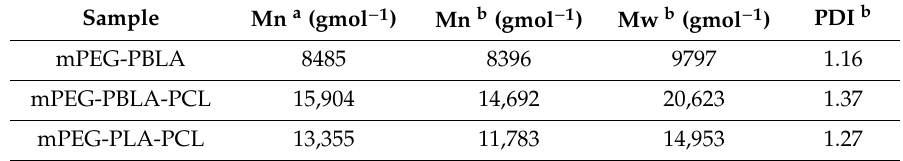
Figure 2. Raman shift of mPEG-P(LA-DSeDEA)-PCL ( A ) and APC traces of block copolymers ( B ). Table 1. Molecular weight and polydispersity profiles of synthesized block copolymers.